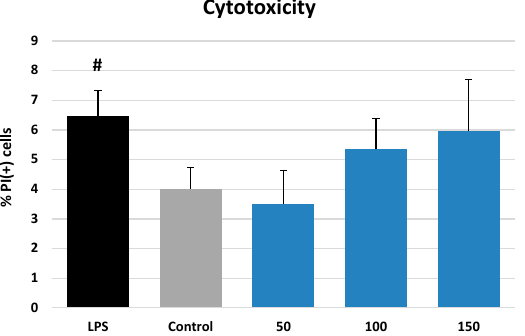
Figure 3. Effect of ME at 50, 100, and 150 µ g/mL on viability (membrane integrity) of neutrophils as indicated by propidium iodide positive PI(+) cells. Data expressed as means ± SD of three independent experiments performed with cells isolated from five independent donors. Statistical significance: # p < 0.05 compared to the non-stimulated control.